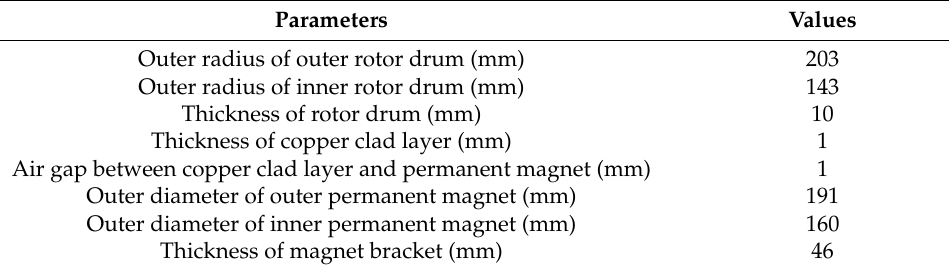
Table 3. Structural parameters of the designed double rotor braking device.